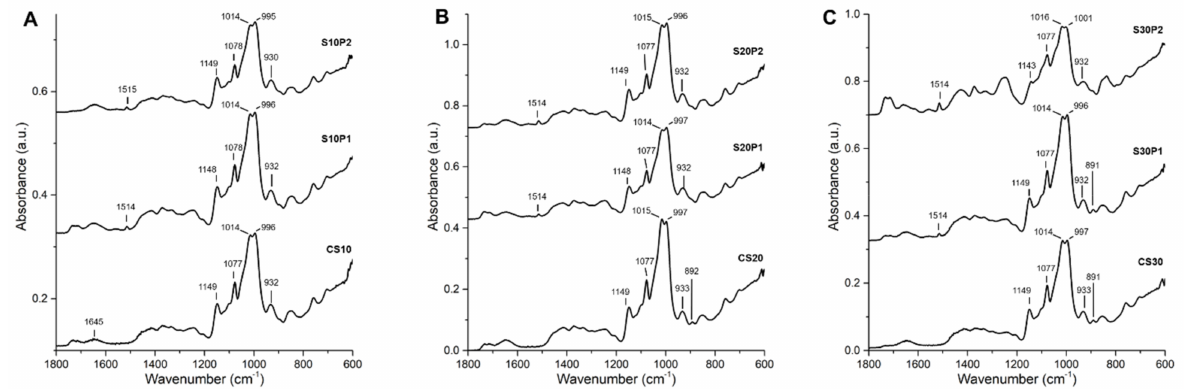
Figure 3. FTIR spectra of rice starch films at ( A ) 10, ( B ) 20 and ( C ) 30% w / w of sorbitol with different drug